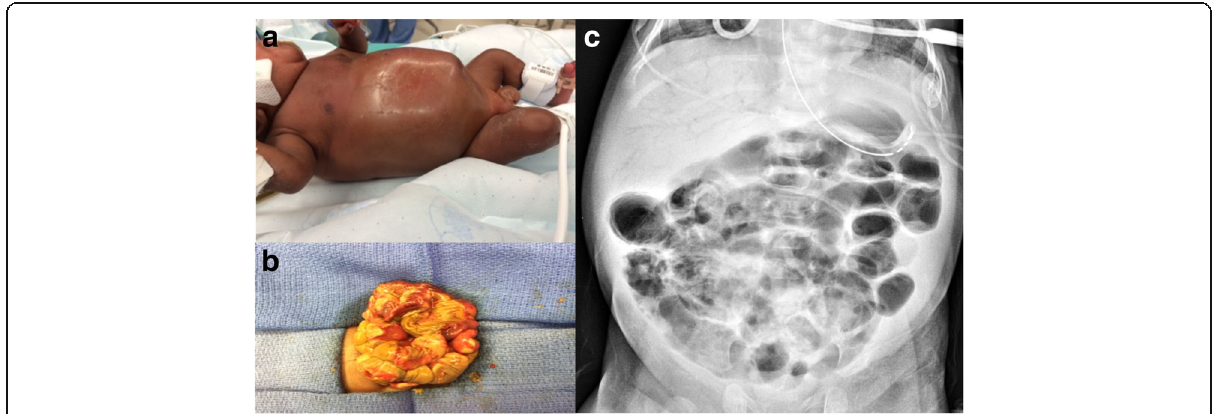
Fig. 1 Clinical findings of Necrotizing Enterocolitis. a Abdominal distension and erythema frequently seen in an infant with necrotizing enterocolitis.